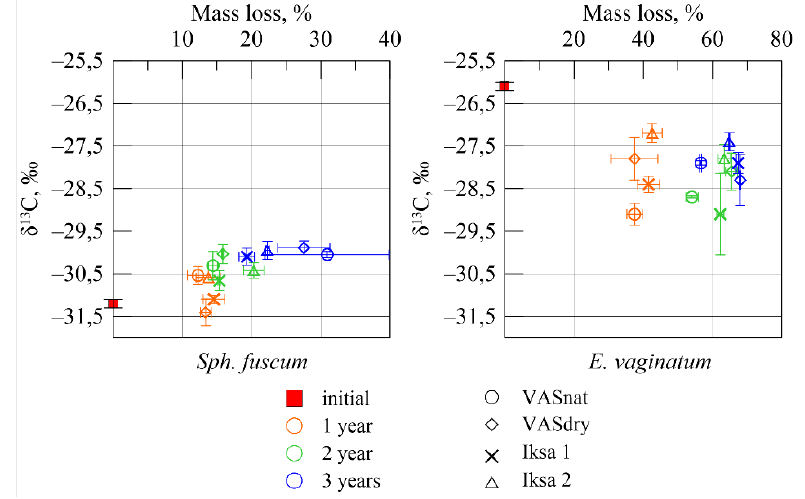
Figure 5. Variability of the carbon isotope composition of peat-forming plants during the biochemi- cal transformation.